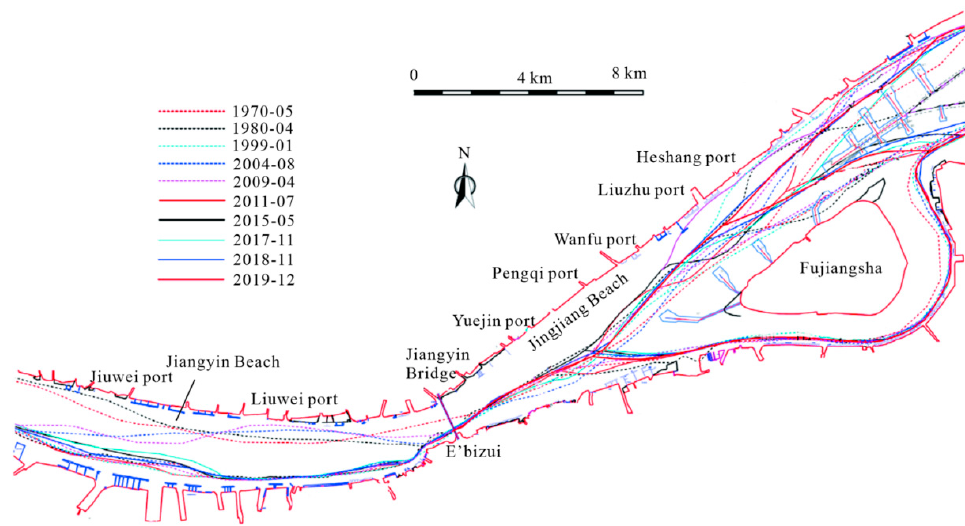
Figure 11. Deep trough changes of Jiangyin–Fujiangsha